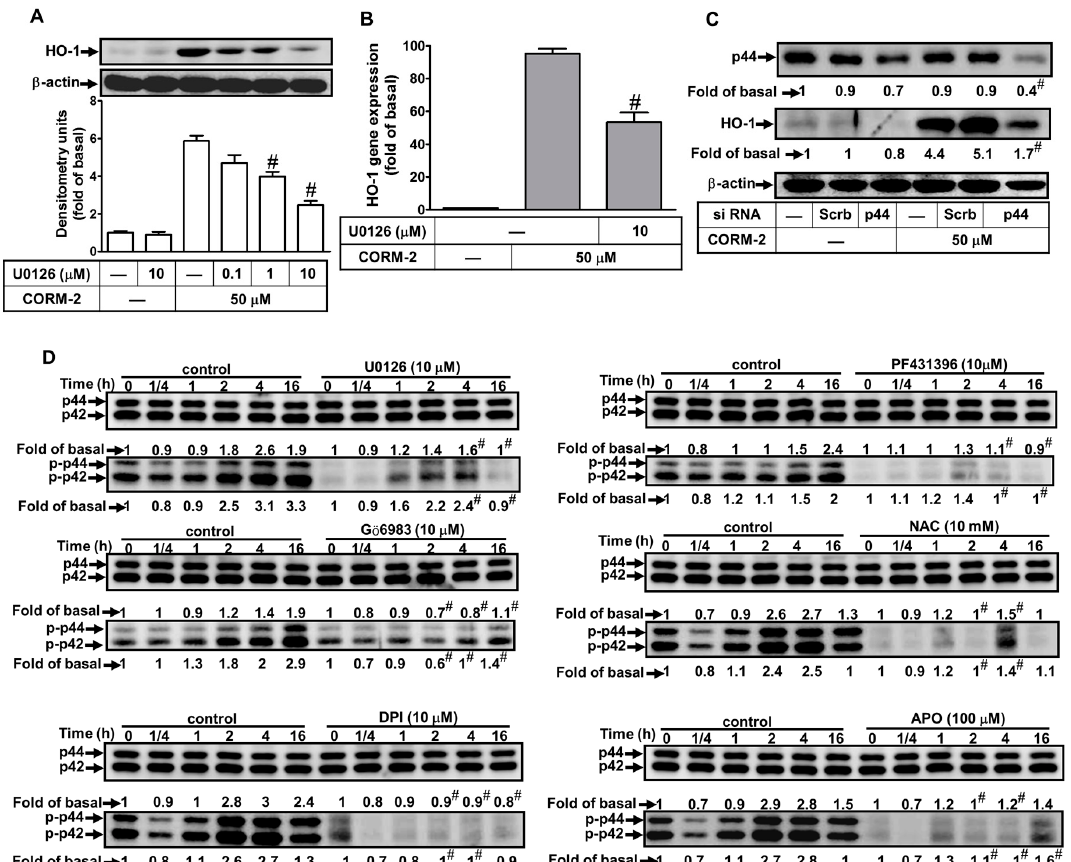
Figure 6. CORM-2-induced HO-1 expression is mediated through extracellular signal-regulated kinase 1/2 (ERK1/2) in HTSMCs. ( A ) Cells were pretreated with U0126 for 1 h, and then incubated with CORM-2 for 24 h. The protein levels of HO-1 and β -actin (served as an internal control) were determined by Western blot. ( B ) Cells were pretreated with U0126 (10 μ M) for 1 h, and then incubated with CORM-2 for 6 h. The mRNA expression of HO-1 was determined by real-time PCR. ( C ) Cells were transfected with either scrambled (Scrb) or p44 siRNA, and then incubated with CORM-2 for 24 h. The levels of p44 and HO-1 protein were determined by Western blot. ( D ) Cells were pretreated with or without U0126 (10 μ M), Gö6983 (10 μ M), PF431396 (10 μ M), NAC (10 mM), DPI (10 μ M), or APO (100 μ M), and then incubated with CORM-2 for the indicated time intervals. The levels of phospho-p42/p44 MAPK and p42/p44 MAPK (served as an internal control) were determined by Western blot. Data are expressed as mean ± SEM of five independent experiments ( n = 5). # p < 0.05, as compared with the cells exposed to CORM-2 alone. Data analysis and processing are described in the section “Statistical Analysis of Data”.